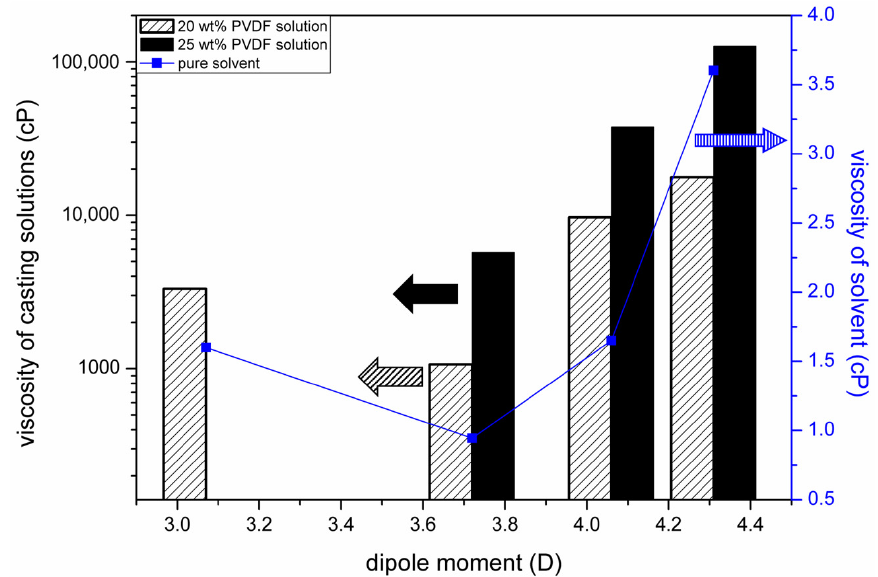
Figure 11. Dependence of the viscosities of solvents and casting solutions on solvent dipole moments.